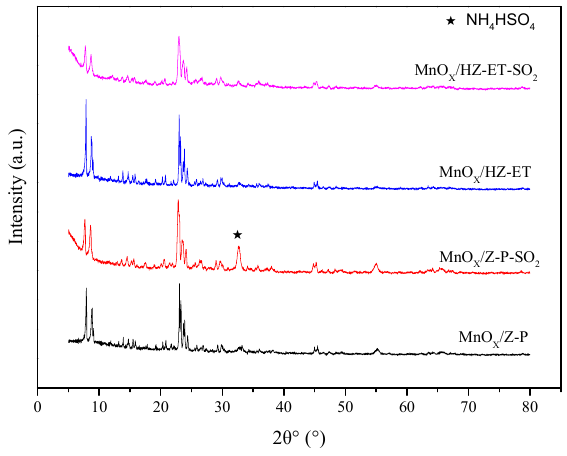
Figure 9. XRD patterns of the catalysts used.